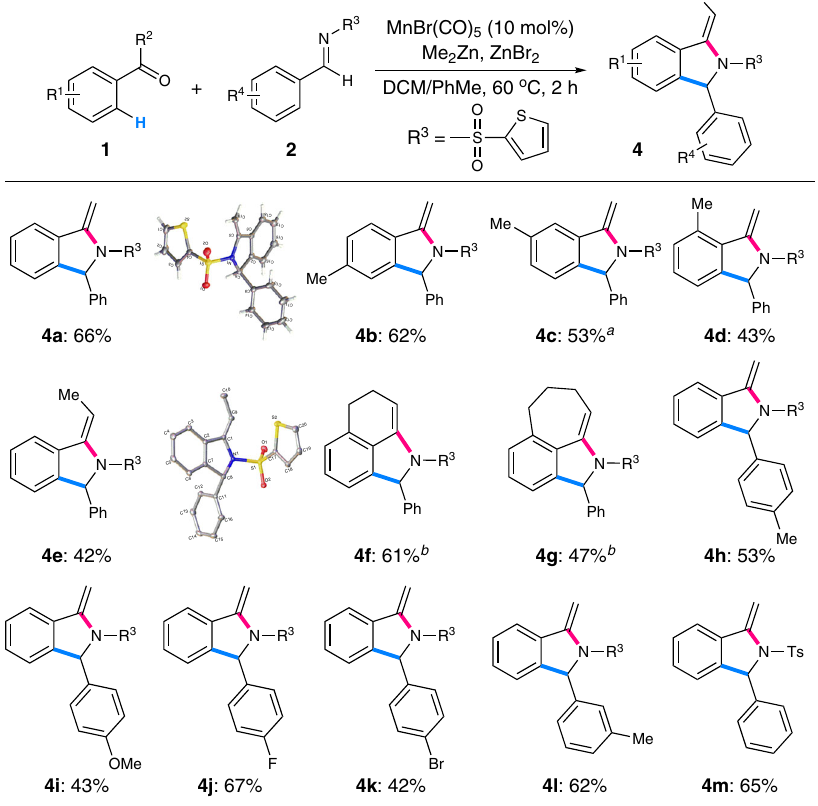
Fig. 6 Substrate scope for the [3 + 2] annulations giving exo -ole fi nic isoindolines 4 . Reaction conditions: 1 (2.0 mmol), 2 (0.5 mmol), MnBr(CO) 5 (0.05 mmol), Me 2 Zn (0.75 mmol, 1.2 M in toluene), ZnBr 2 (0.5 mmol), DCM (0.1 M), 60 °C, 2 h. a Combined yield of two regioisomers (3.9/1), major isomer 4c was shown. b Me 2 Zn (2.0 equiv.), 100 °C, 10 h. DCM dichloromethane